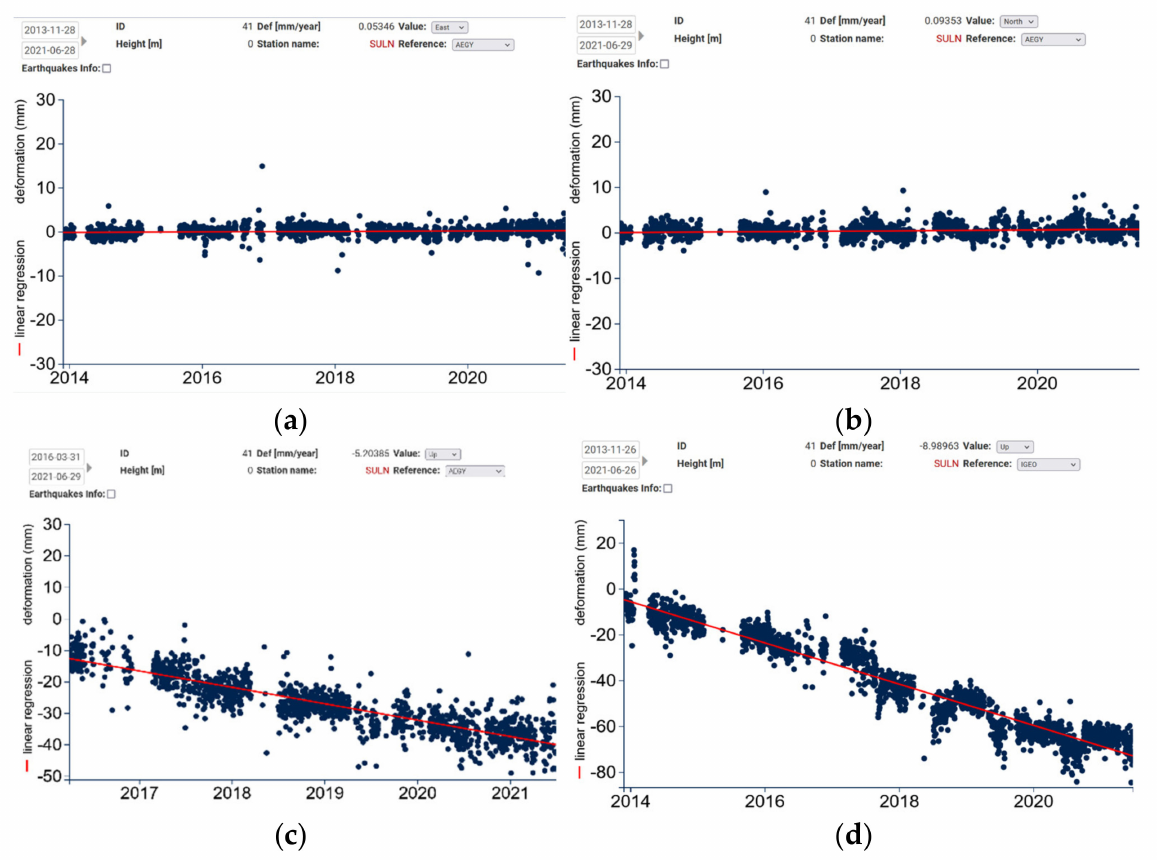
Figure 14. On-the-fly differential measurements between selected GNSS stations: ( a ) east, SULN vs. AEGY; ( b ) north, SULN vs. AEGY; ( c ) up, SULN vs. AEGY; ( d ) up, SULN vs.